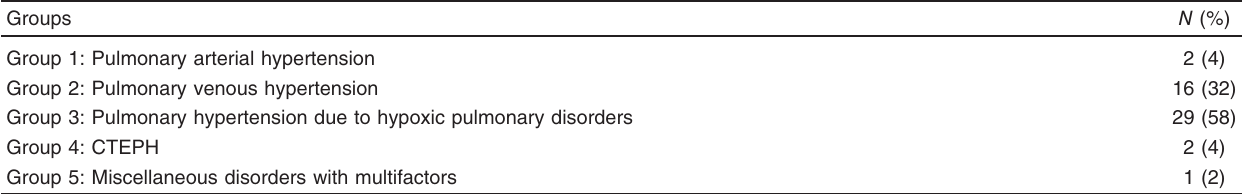
Table 15 Number of patients in each group of pulmonary hypertension according to European Respiratory Society 2015 classification